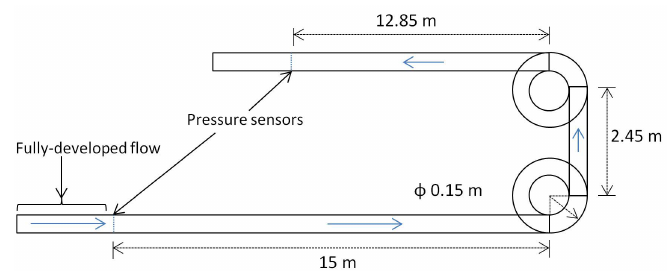
Figure 6. A schematic of the experimental set-up showing the location of the pressure sensors and the dimensions of the various sections [49] (courtesy: Stichting Deltares).